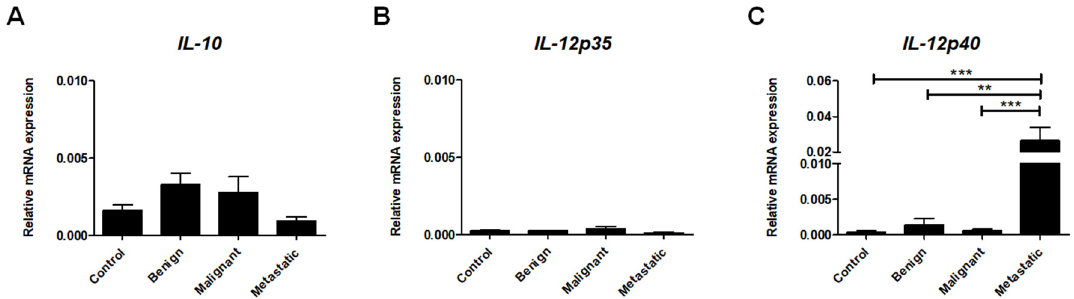
Figure 5. The expression of inflammatory cytokines at the mRNA level in canine mammary tumors. Relative gene expression of IL-10 ( A ), IL-12p35 ( B ), and IL-12p40 ( C ) in healthy mammary gland tissue (Control) and in benign, malignant, and metastatic canine mammary tumors. The results are presented as the mean ± SEM. A one-way ANOVA and Tukey HSD post hoc test were applied. Significance levels are indicated as follows: ** p < 0.01; *** p < 0.001.